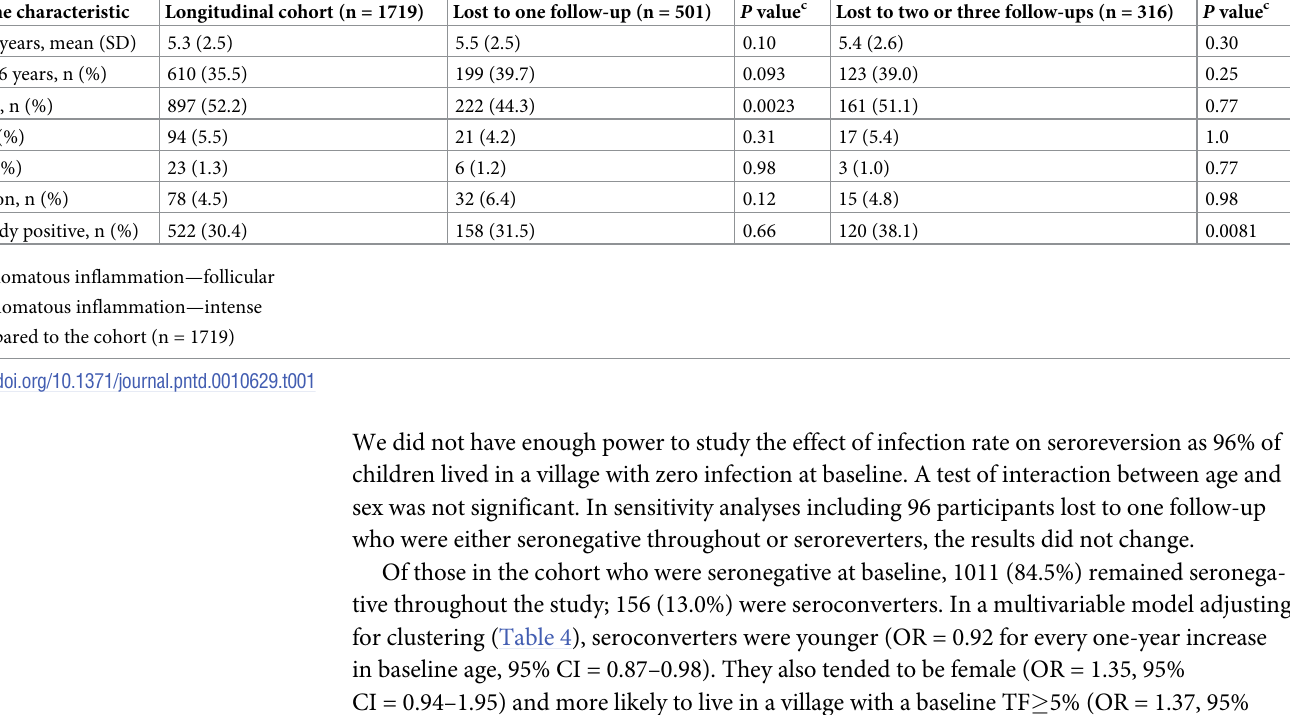
Table 1. Baseline characteristics of the cohort who completed all follow-up visits versus those who missed one or more follow-ups. Baseline characteristic